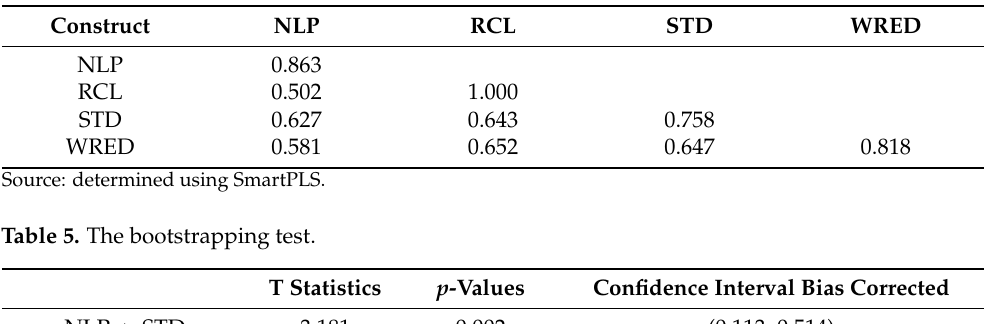
Table 4. Fornell–Larcker criterion.